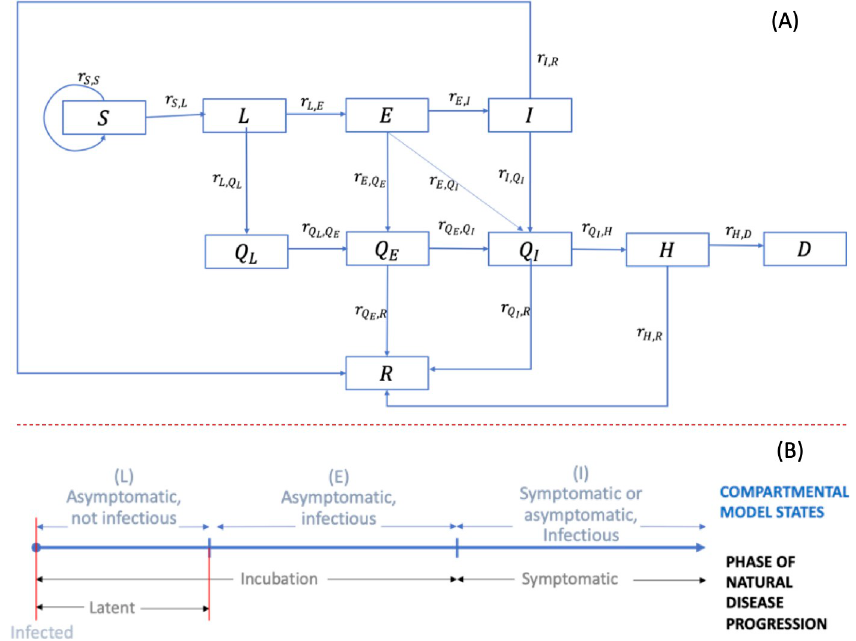
Fig 1. Overview of the extended SEIR compartmental model. (A) Compartmental model flow diagram. (B) Natural disease progression of SARS-COV-2 virus in infected patients. S = susceptible, L = exposed and not infectious (Latent stage) (asymptomatic), E = asymptomatic and infectious, I = symptomatic and infectious, Q L = exposed and not = asymptomatic and infectious and Quarantined (diagnosed), Q infectious (Latent) and Quarantined (diagnosed), Q E = Infectious and Quarantined (diagnosed), H = Hospitalized, R = Recovered, and D = Deaths.